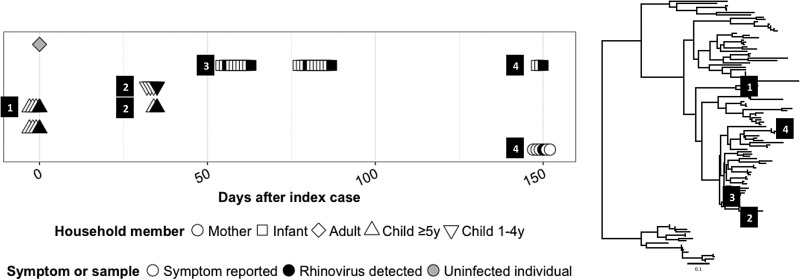
Multiple HRV infection clusters within a single household. (Left) Timeline of symptoms (empty symbols) and HRV-positive specimen collection (black symbol) with each row representing one household member. (Right) HRV phylogenetic tree. Numbered squares on the phylogenetic tree represent an HRV genotype and correspond to numbered squares to left of the HRV specimen on the illness timeline. HRV specimens without a numbered square were not sequenced.